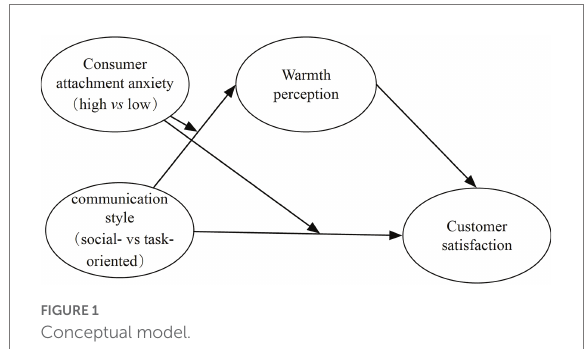
FIGURE 1 Conceptual